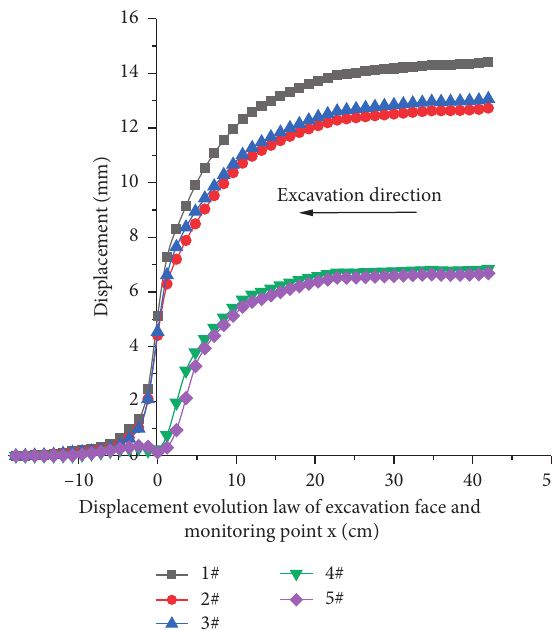
Figure 20: Deformation law of tunnel measuring